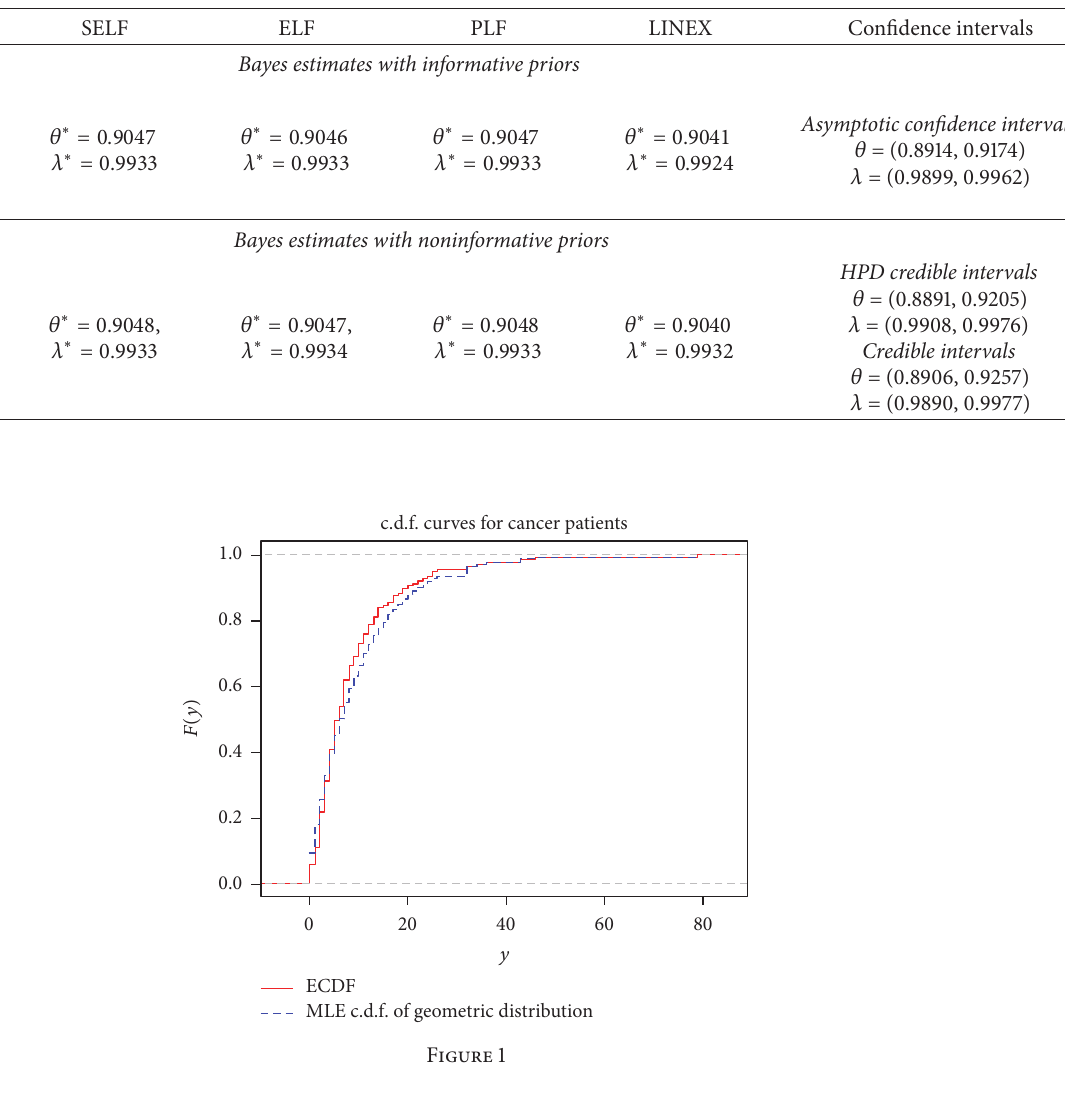
Table 3: Estimates for real data example.